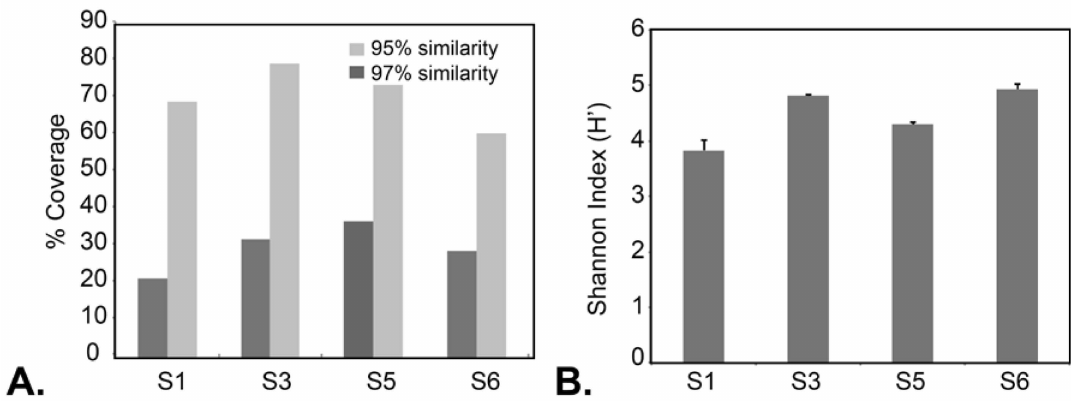
Figure 6. ( A ) Estimated percent sequencing coverage within each 16S rRNA gene amplicon library based on a 5% and 3% genetic cutoff. ( B ) Bacterial diversity for each 16S rRNA gene amplicon library based on the Shannon